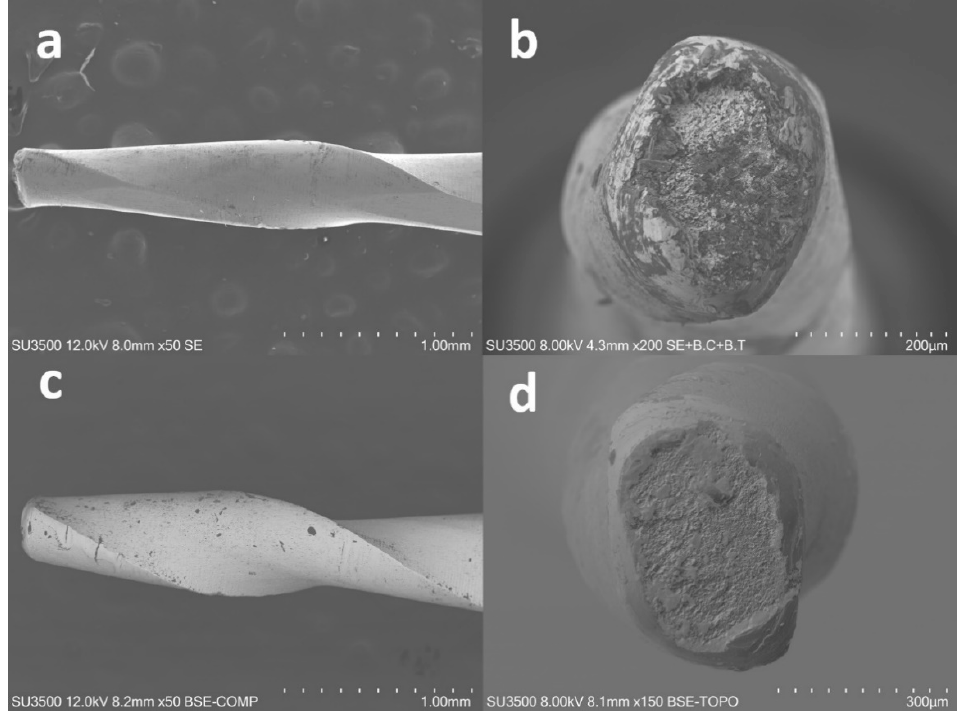
Figure 1. Lateral and cross-sectional aspect of flat-designed ( a , b ) and prototype instruments ( c , d ) at field emission scanning electron microscope (FE-SEM).